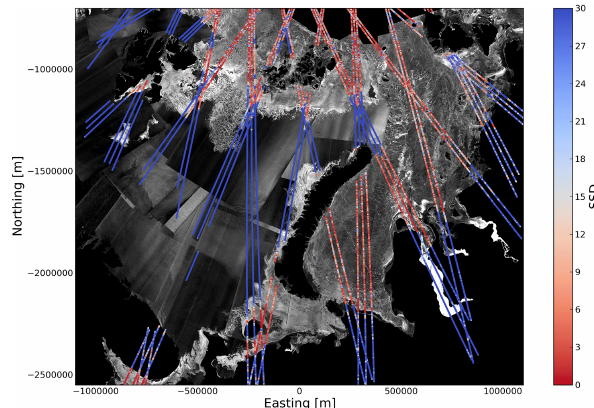
Figure 1. CS-2 pulse peakiness (1–5 March 2014) plotted on a RS-2 SAR composite (5 March 2014).